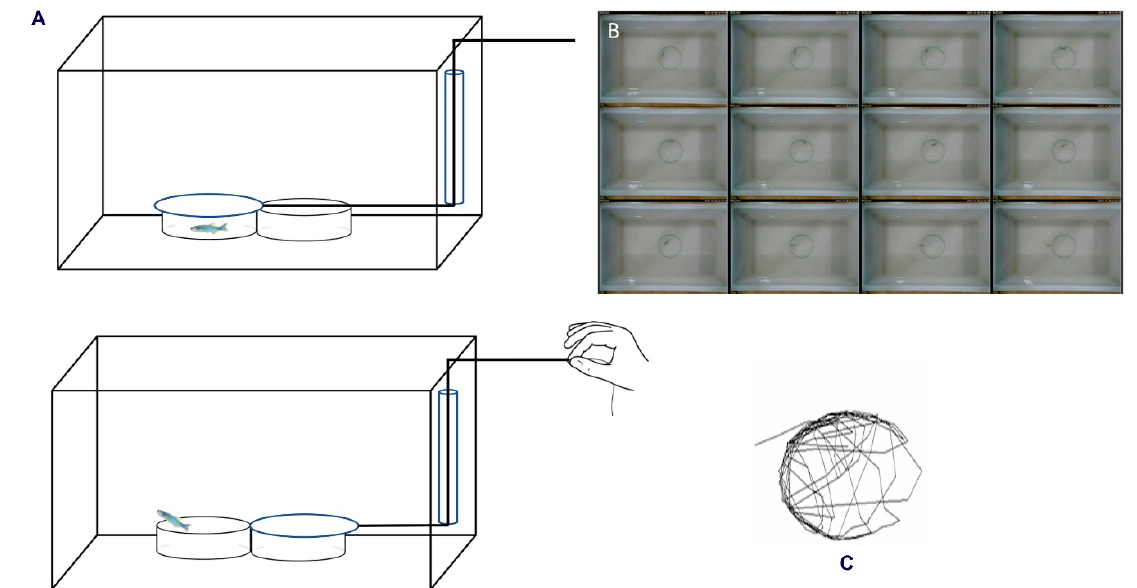
Figure 1. ( A ) Illustration of the experimental design showing acclimatisation of zebrafish in the confined space for 12–15 min, after which the dish was opened for the observation of the behaviour. This setup was used to study the habituation of zebrafish in confinement; ( B ) representation of the movement of zebrafish in the confined space, including crossing over the huddle during the experiment. ( C ) The movement pattern tracked using the tracker software. Table 1. Ethogram describing the behaviour category and its definition, as observed in the present study.